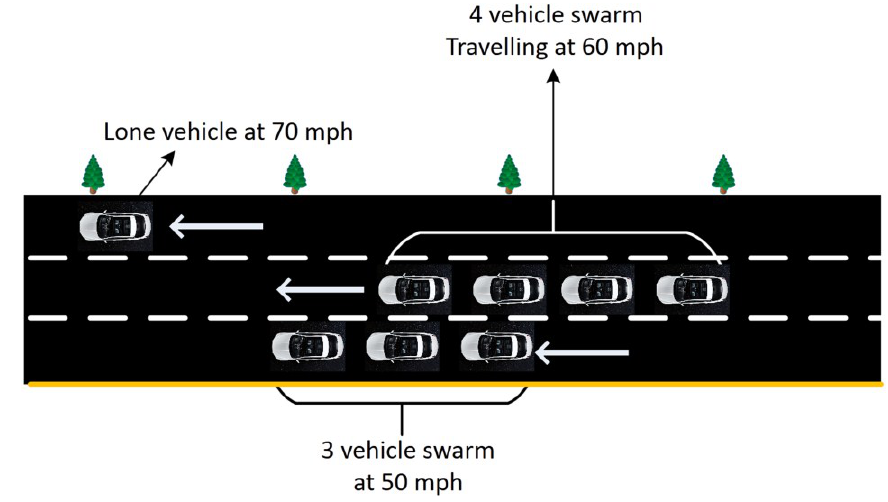
Figure 3. Vehicle swarm